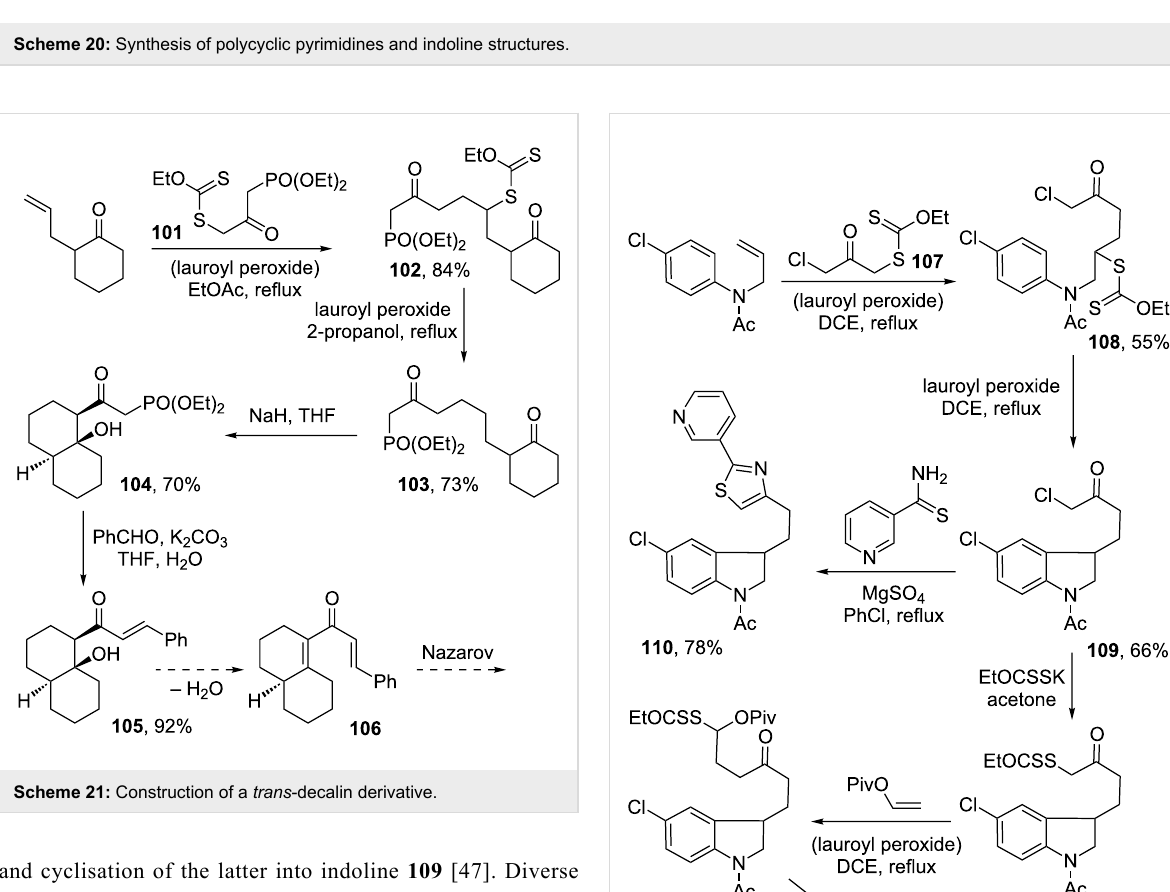
Scheme 20: Synthesis of polycyclic pyrimidines and indoline structures.